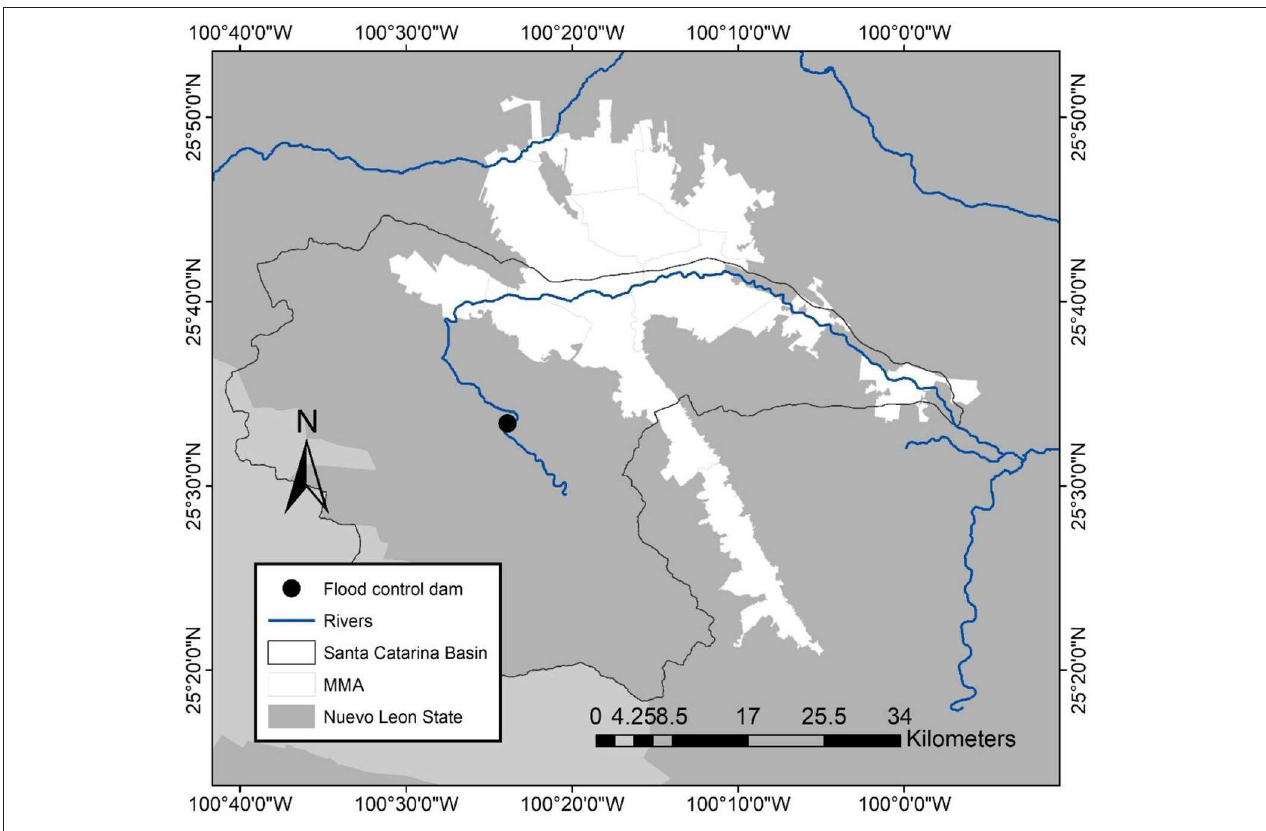
FIGURE 2 | The Santa Catarina river and the Monterrey Metropolitan